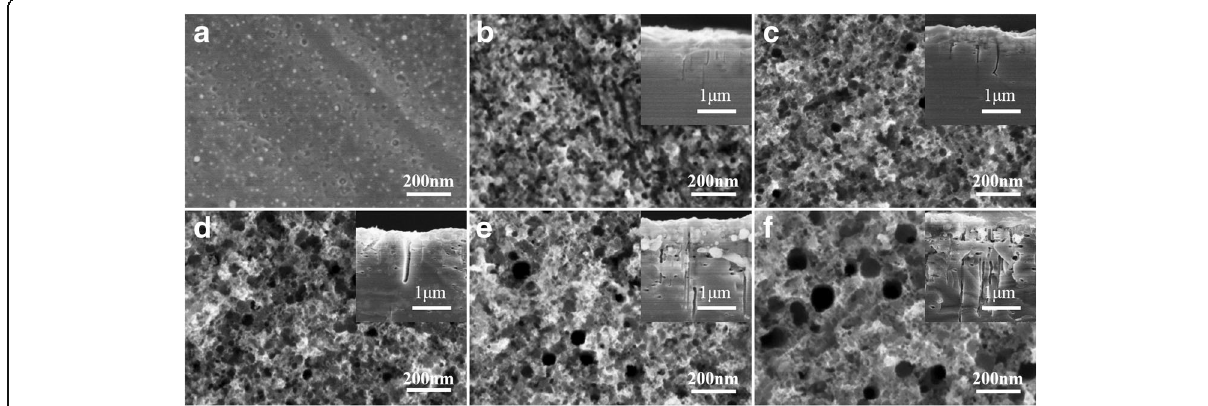
Fig. 2 SEM images of nanoporous silicon (cross section in insert) with different processing time. SEM images of nanoporous silicon: a as-fabricated and b – f nanoporous silicon and cross section in inset for 1, 2, 3, 4, and 5 min processing at 35